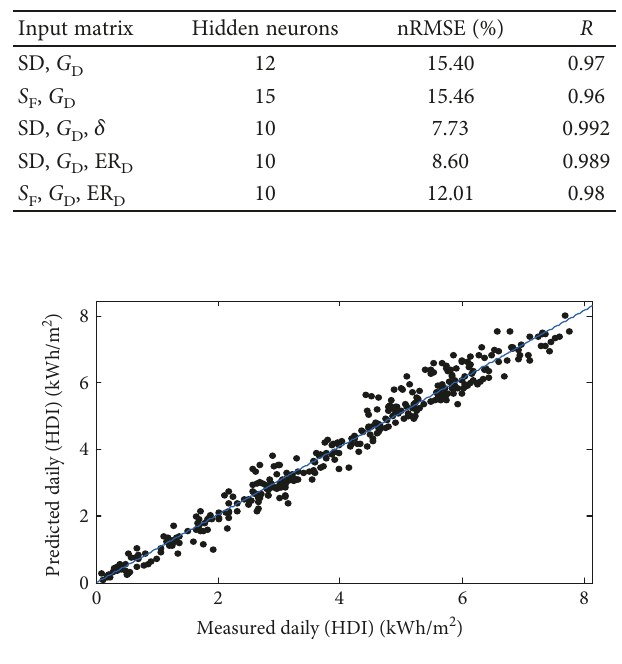
Figure 8: Regression plot of measured and predicted daily horizontal direct irradiation.